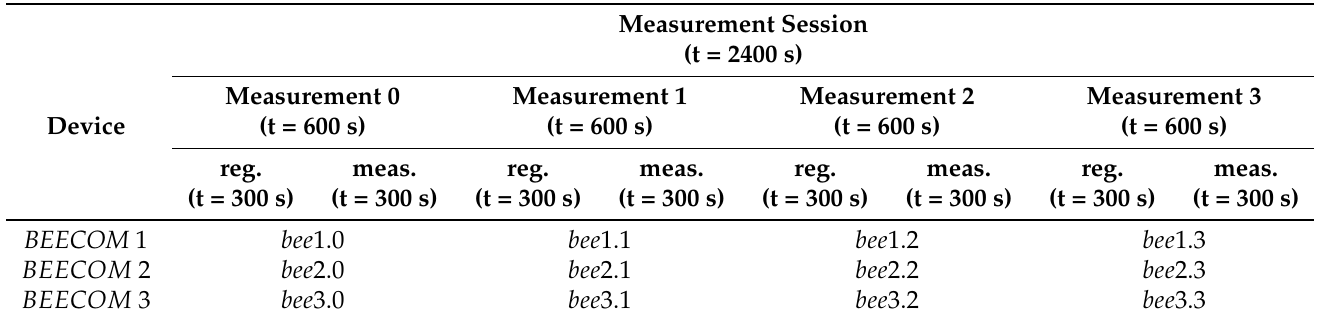
Table 4. The scheme of the measurement session including the duration of each phase and the names of the obtained measurements. Legend: reg.—regeneration phase; meas.—measurement